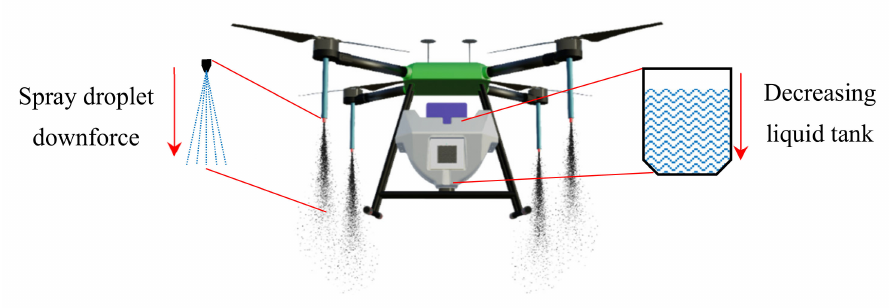
Figure 1. Agricultural sprayer UAV (Quadrotor).